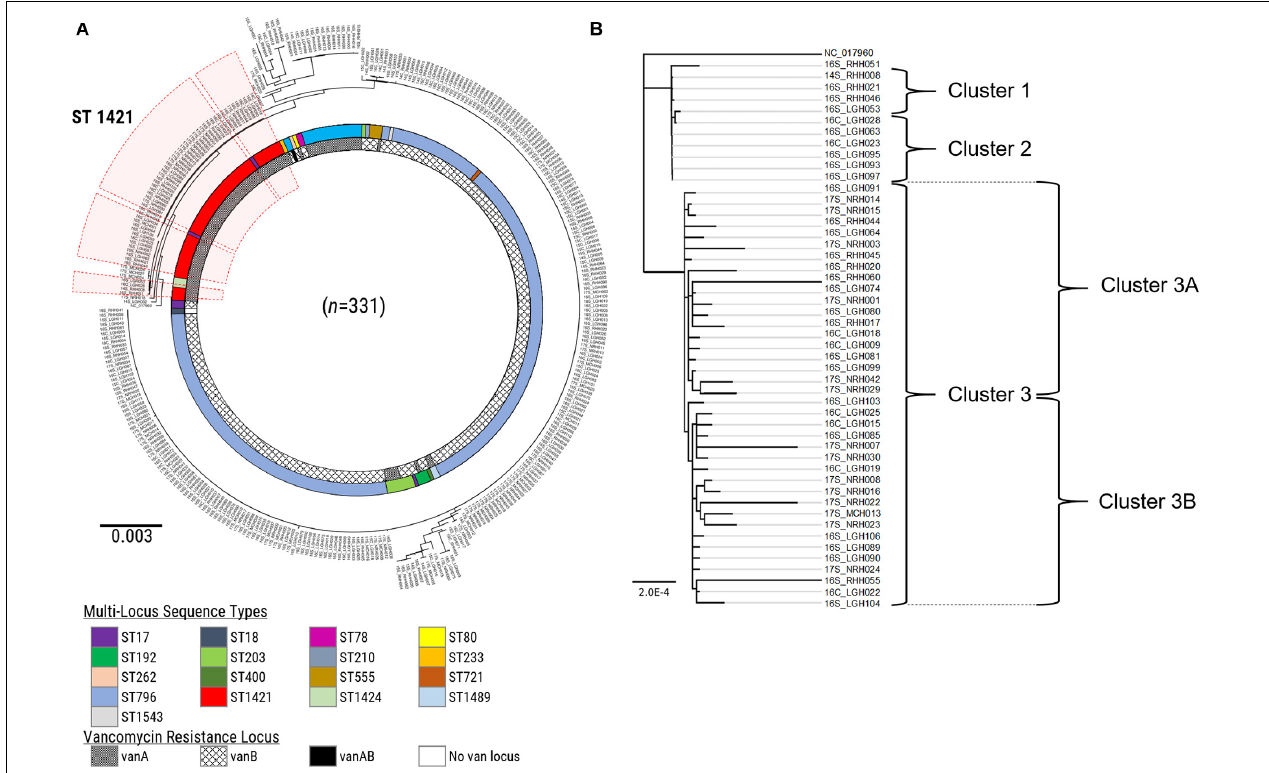
FIGURE 4 | SNP-based analysis of vancomycin-resistant Enterococcus faecium (VREfm) isolates. (A) A SNP-based maximum-likelihood (PhyML) phylogenetic tree was generated from the VREfm isolates collected from the four public hospitals in Tasmania (RHH, Royal Hobart Hospital; LGH, Launceston General Hospital; NRH, North West Regional Hospital; MCH, Mersey Community Hospital) that were whole genome sequenced ( n = 331) with reference genome Enterococcus faecium DO (TX16_NC-017960) to root the tree. Multi-locus sequence types (MLST) and vancomycin ( van )-resistance loci are indicated. The clade of ST1421 isolates is highlighted in red. (B) Clades from the PhyML phylogenetic tree of VREfm isolates belonging to multi-locus sequence type ST1421 ( n = 50) show concordance with the clusters determined by core-genome MLST (cgMLST) with Cluster 3 sub-dividing further into Clusters 3A and